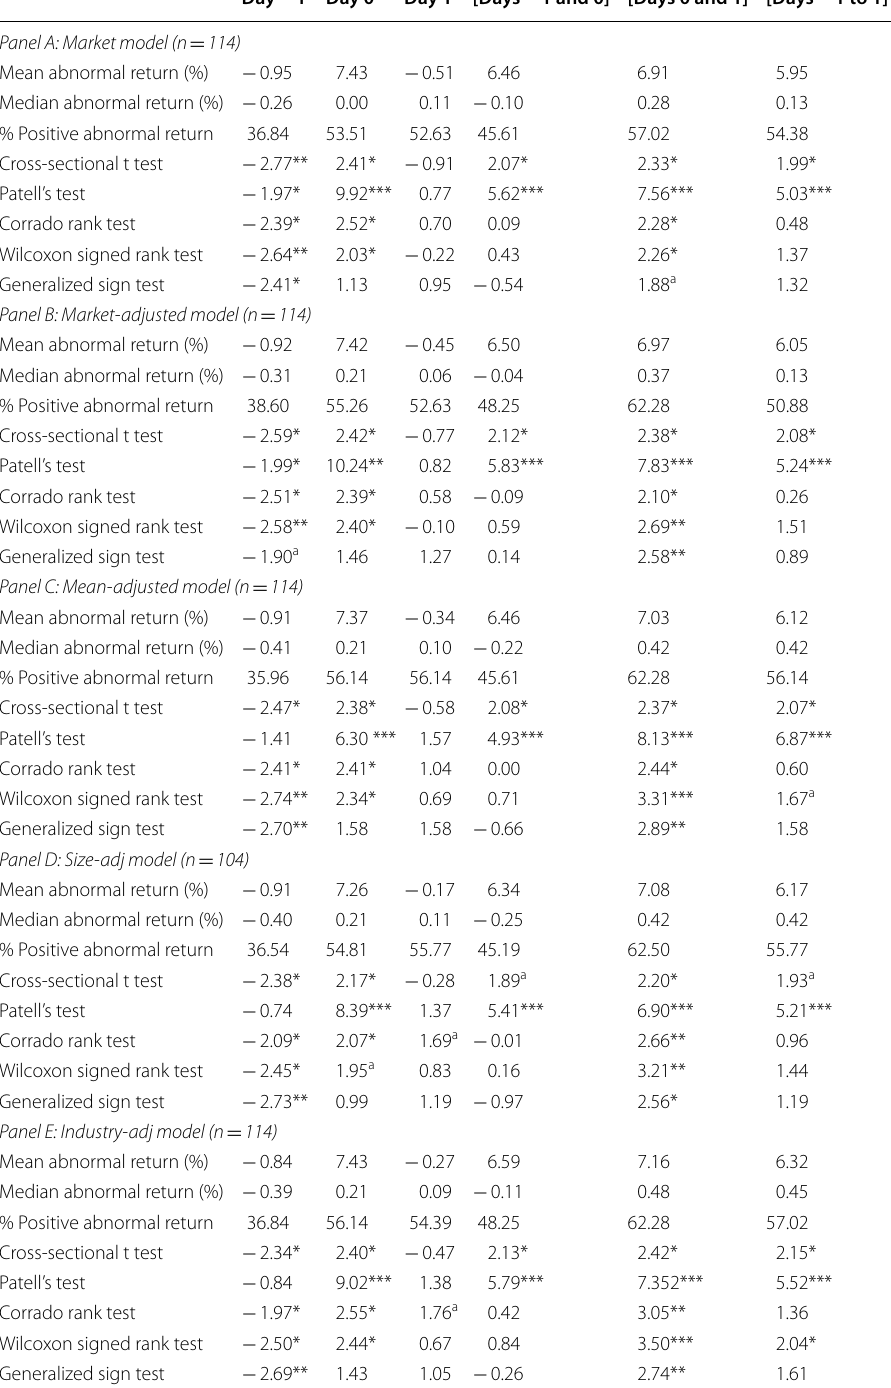
Table 3 Event study